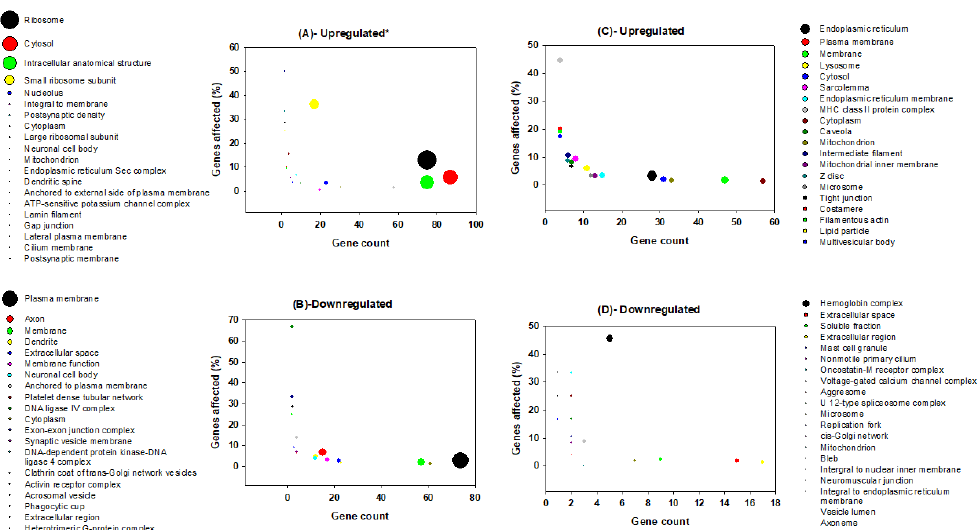
Figure 5. Graphical representation of cellular component terms for genes that are up-regulated in the brain ( A ), down-regulated in the brain ( B ), up-regulated in the liver ( C ), and down-regulated in the liver ( D ) following rapid eye movement sleep deprivation in rats. The x -axis shows gene count, and the y -axis shows the percentage of genes a ff ected. The bubble size represents the log transformed p - value [Y = −0.5*log(Y)] of the respective cellular component. To fit the bubble size, the p -value in 5A* was normalized with formula [Y = −0.5*log(Y)/2]. A bigger bubble size indicates a more significantly affected given process, and thus, a lower p -value. The top 20 terms are displayed for each category.